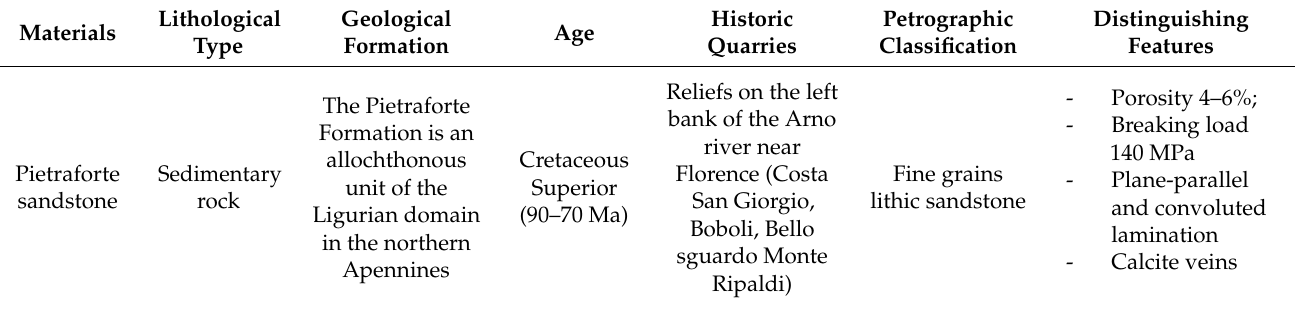
Table 1. Summary list of the properties of the Pietraforte sandstone.